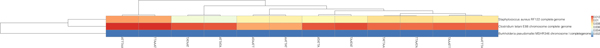
The AAATTT-Spectrum set test. The sequence data is applied to our base composition analysis to determine its relatedness.